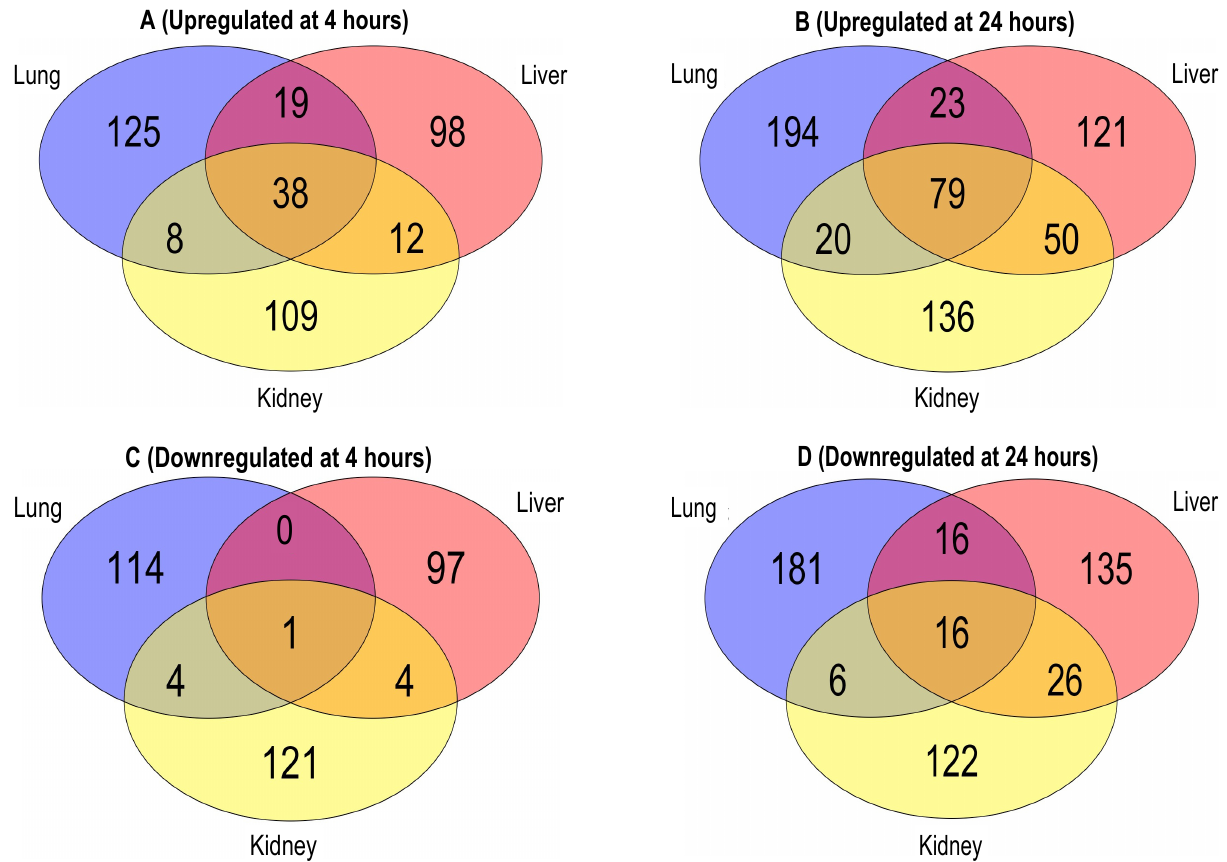
Figure 3. Venn diagrams of the EC upregulated proteins at 4 h (panel A ); upregulated proteins at 24 h (panel B ); downregulated proteins at 4 h (panel C ); and downregulated proteins at 24 h (panel D ).